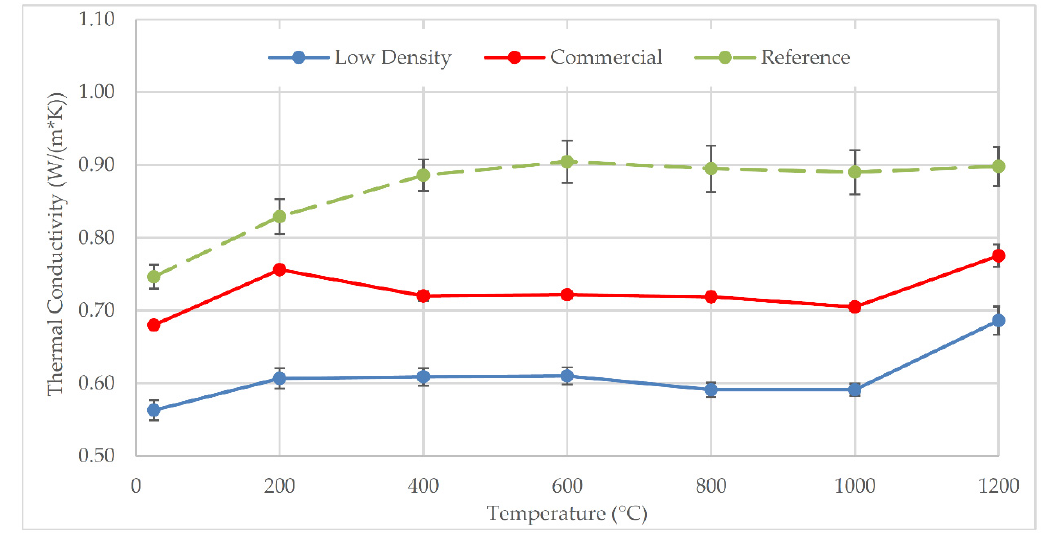
Figure 8. As-produced coating thermal conductivity versus measurement temperature.